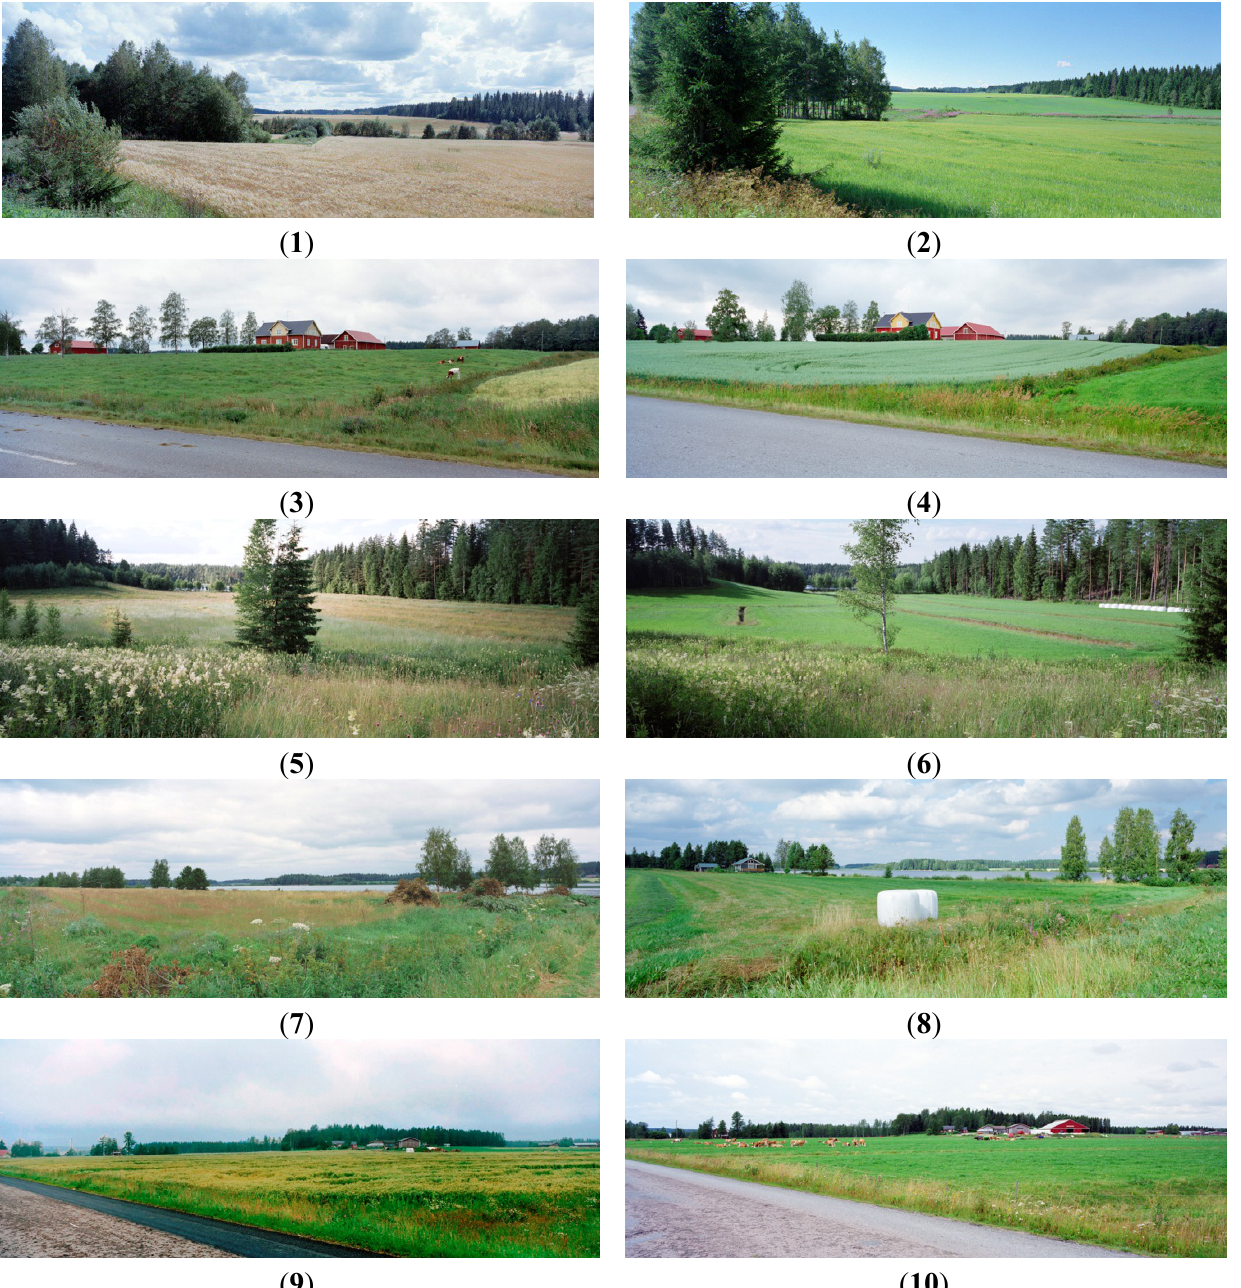
Figure 1. ( 1 – 10 ) Photographs used in the survey (colour versions, late summer on the left, mid-summer on the